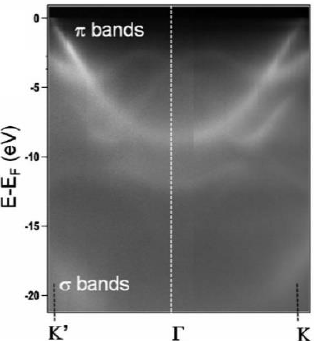
Figure 2. Electronic structure of monolayer EG on 3C-SiC(111) by ARPES. Reprinted with permission from Reference [19]. Copyright (2010) by American Physical Society.